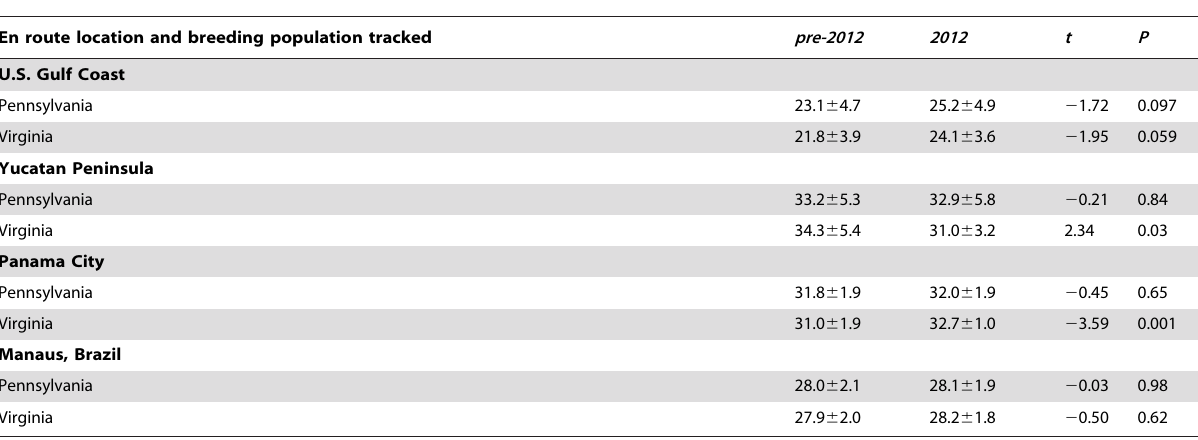
En route location and breeding population